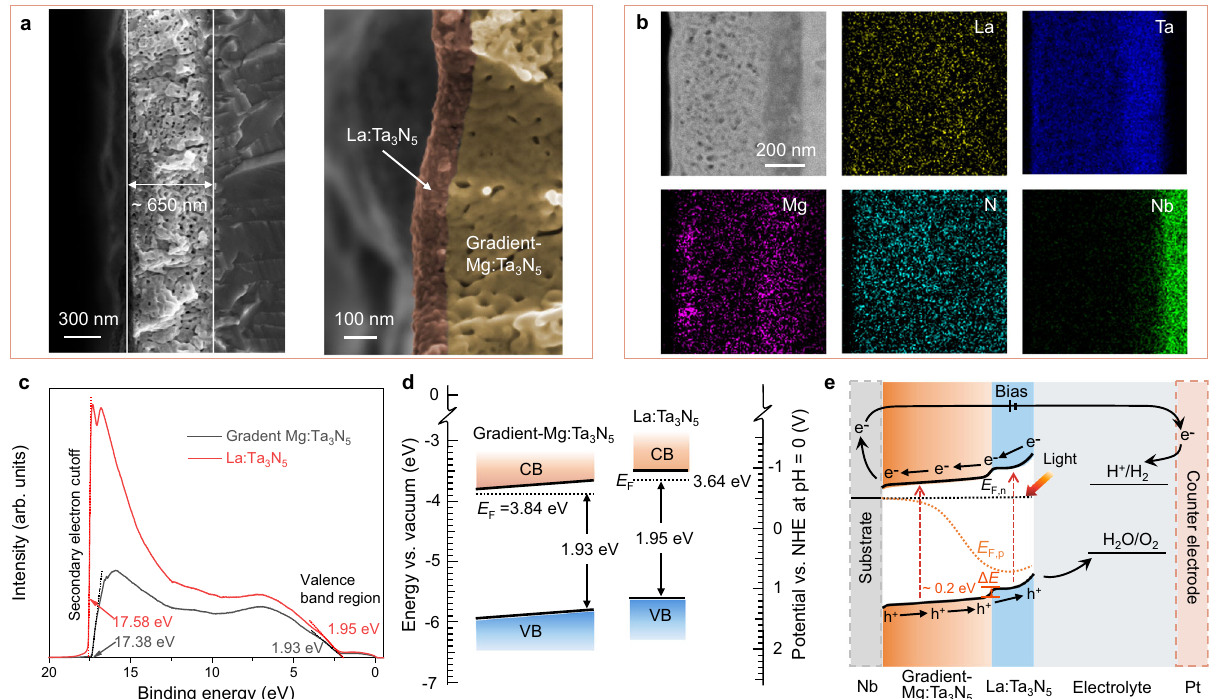
Fig.4|ElectronmicroscopicandbandedgeenergeticscharacterizationsofNb/